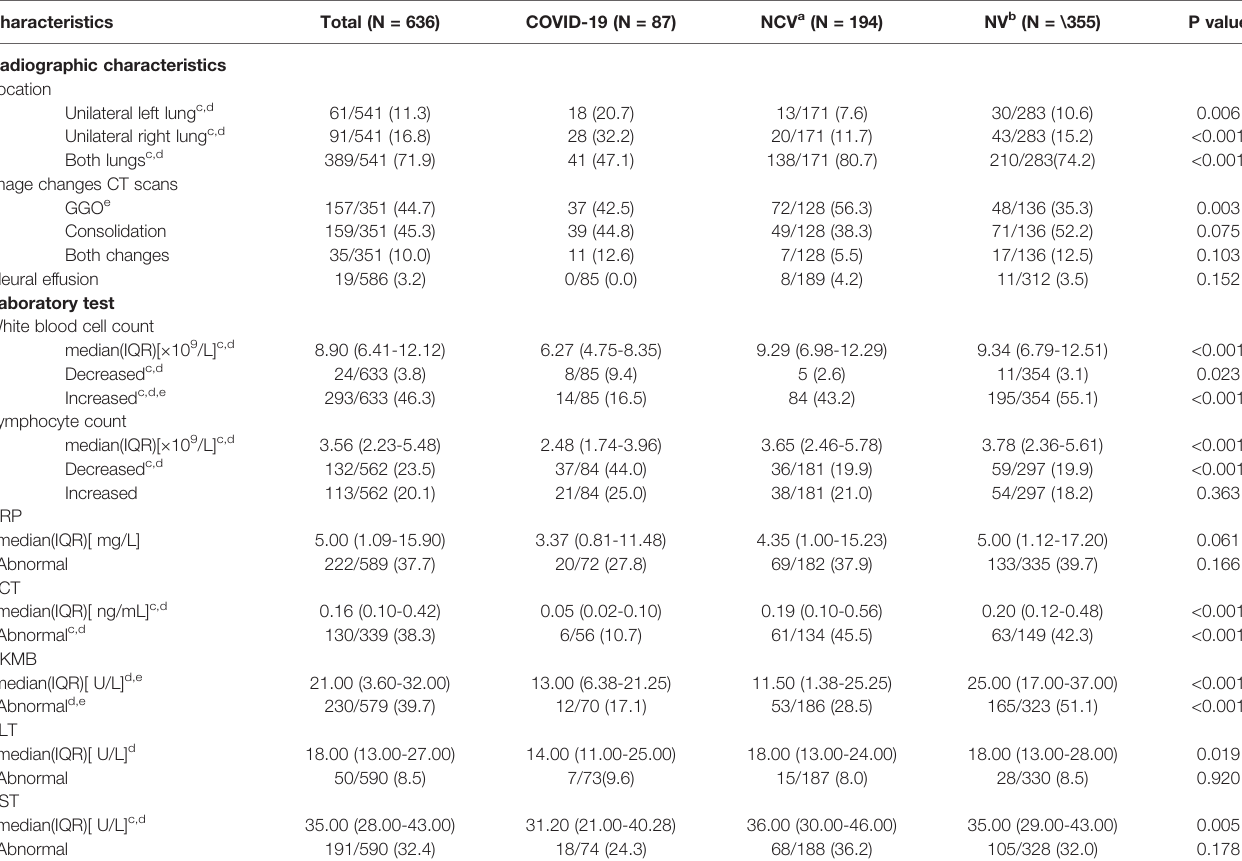
TABLE 2 | Radiographic characteristics and laboratory fi ndings of patients among the three pneumonia groups.